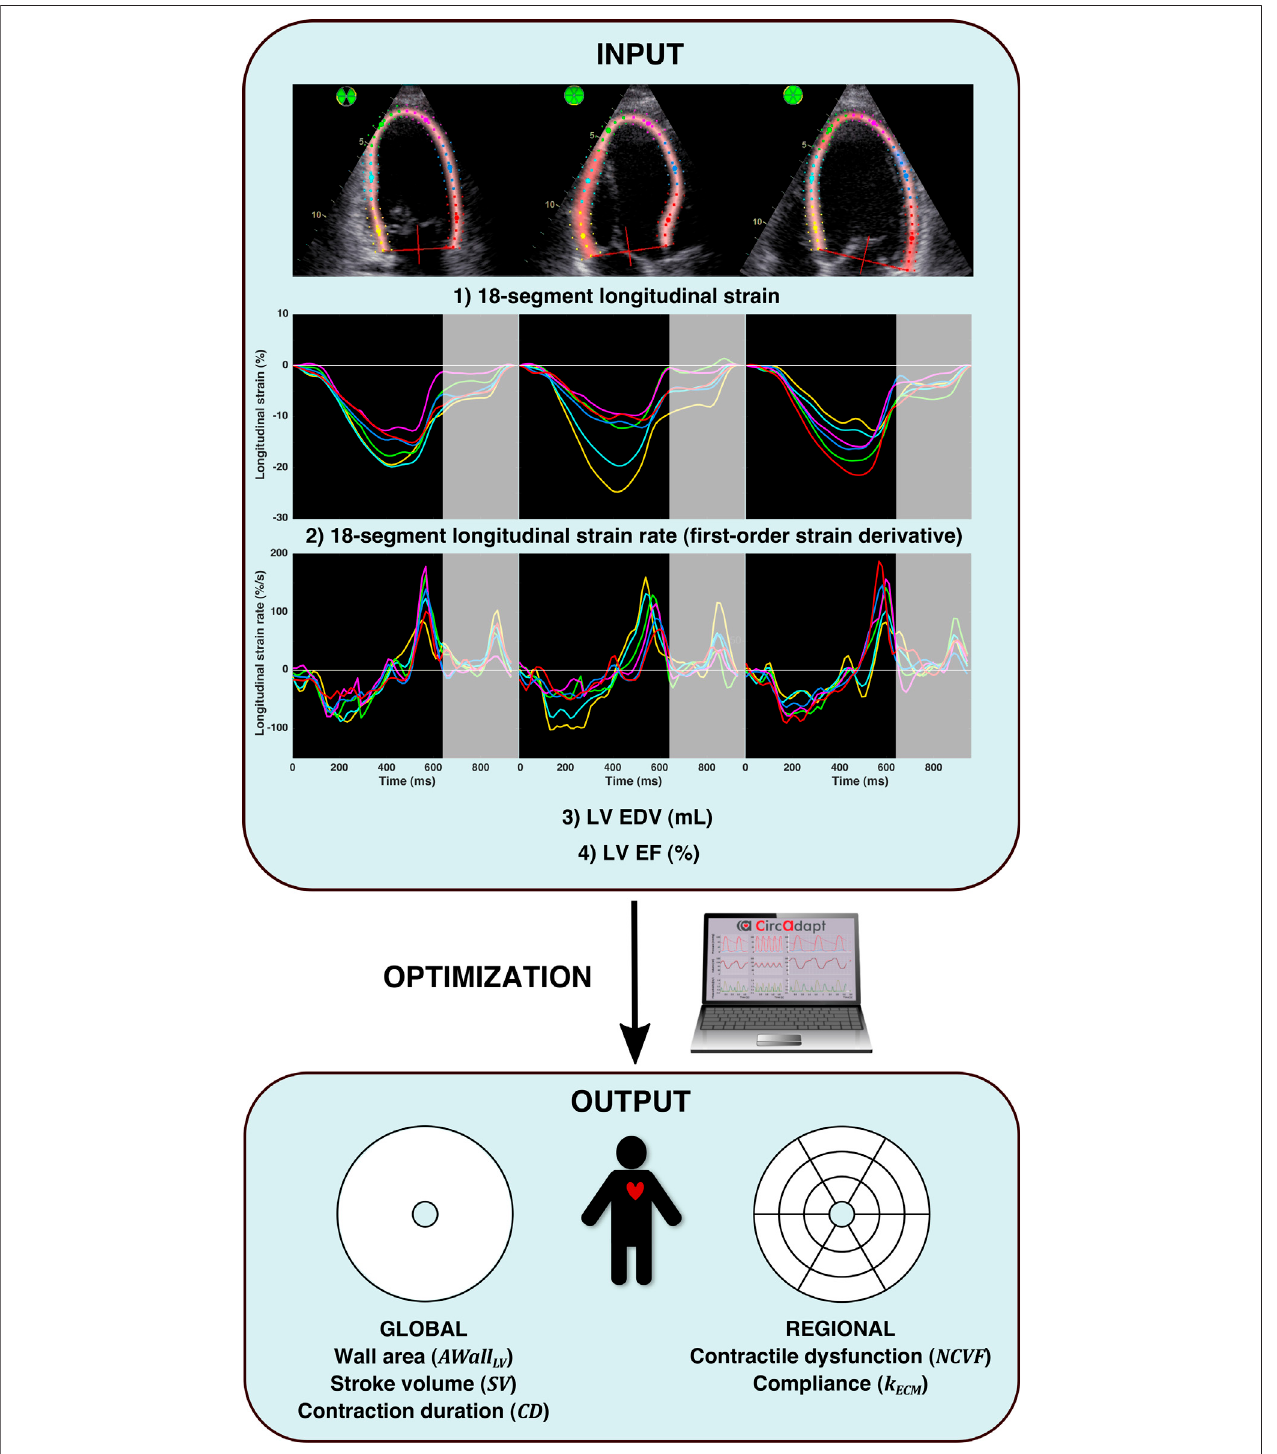
FIGURE 2 | Patient-speci fi c parameter estimation protocol. The input of the optimization algorithm (INPUT) consisted of 1) 18-segment longitudinal strain, 2) 18- segment longitudinal strain rate (calculated as the fi rst-order time derivative of strain), 3) LV end-diastolic volume (EDV), and 4) LV ejection fraction (EF). Strain and strain ratesignalswereanalyzeduntilearlydiastole,asindicatedbythegray-enhancedpartsofthestrainandstrainratesignals.Fornumericaloptimization(OPTIMIZATION),a multi-swarmparticleswarmoptimization(MSPSO) algorithmsimilartotheonepreviouslydescribedinthestudybyVanOstaetal.(2021)wasrun,whichestimated (OUTPUT): global LV wall area, global stroke volume, global ventricular contraction duration, regional contractile dysfunction, and regional compliance.